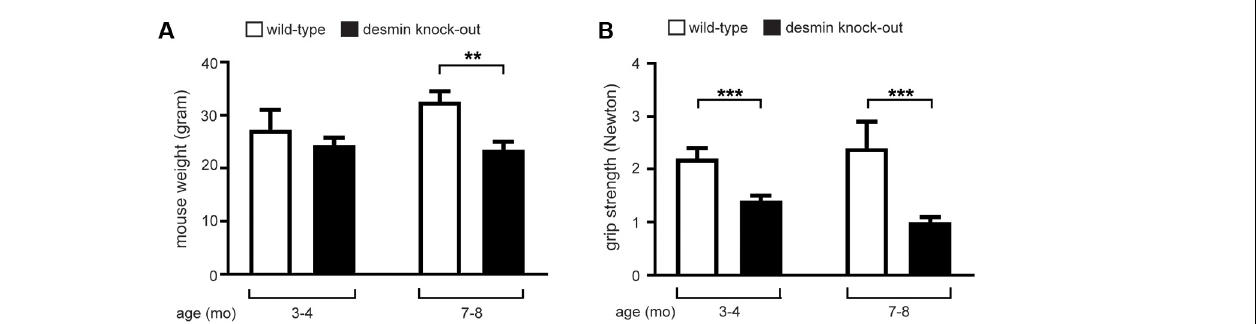
FIGURE 1 | Desmin knock-out mice show reduced muscle strength and have a lower body weight with advancing age. (A) For 3–4 months old desmin knock-out mice, a total of three wild-types and four mutant mice were measured. For 7–8 months old desmin knock-out mice, a total of four wild-types and five mutant mice were measured. Statistical significance was determined by unpaired two-tailed t -test (** P < 0.01). (B) Newton meter measurements of muscle force of desmin mutant mice showed significant muscle weakness. For 3–4 months old desmin knock-out mice, a total of three wild-types and four mutant mice were measured. For 7–8 months old desmin knock-out mice, a total of four wild-types and five mutant mice were measured. Statistical significance was determined by unpaired two-tailed t -test (*** P <